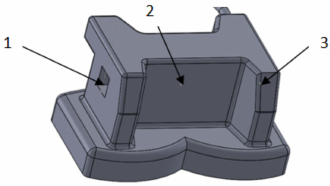
Figure 17. Three guide points attached to a tube.